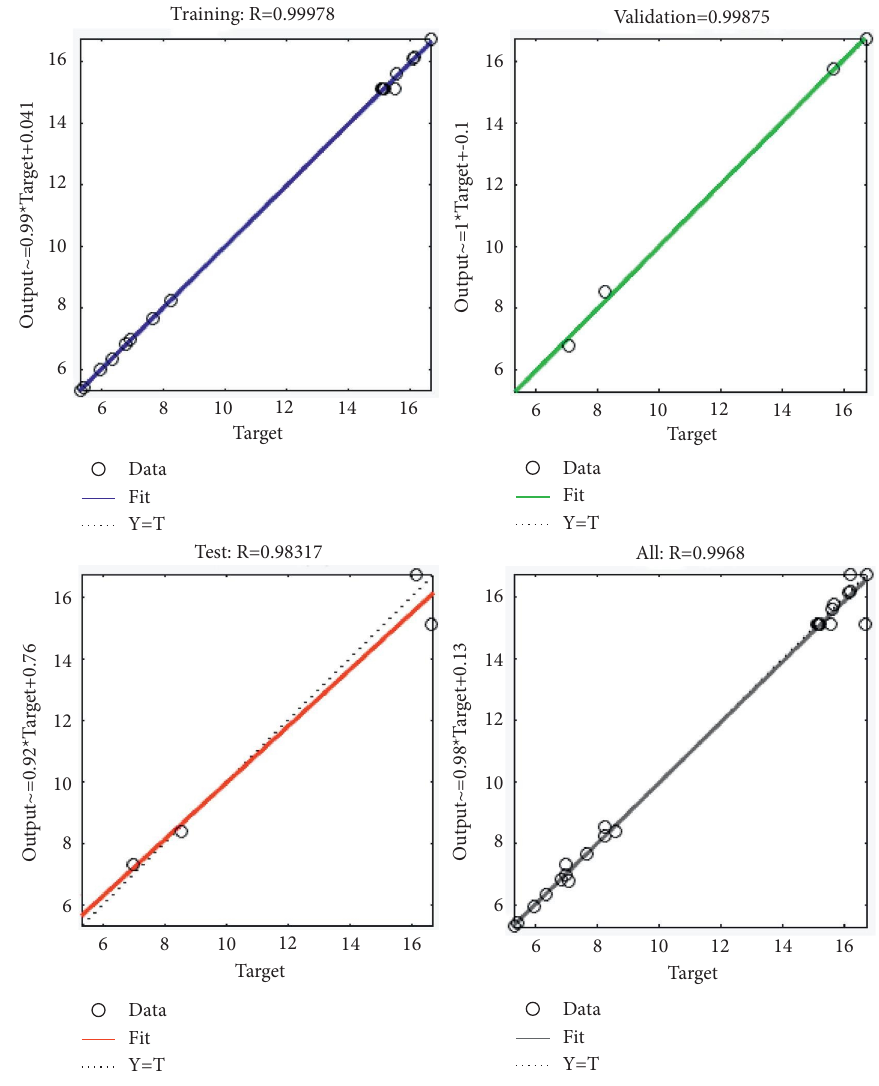
Figure 22: Fitting degree diagram. Table 9: Error between the prediction and test